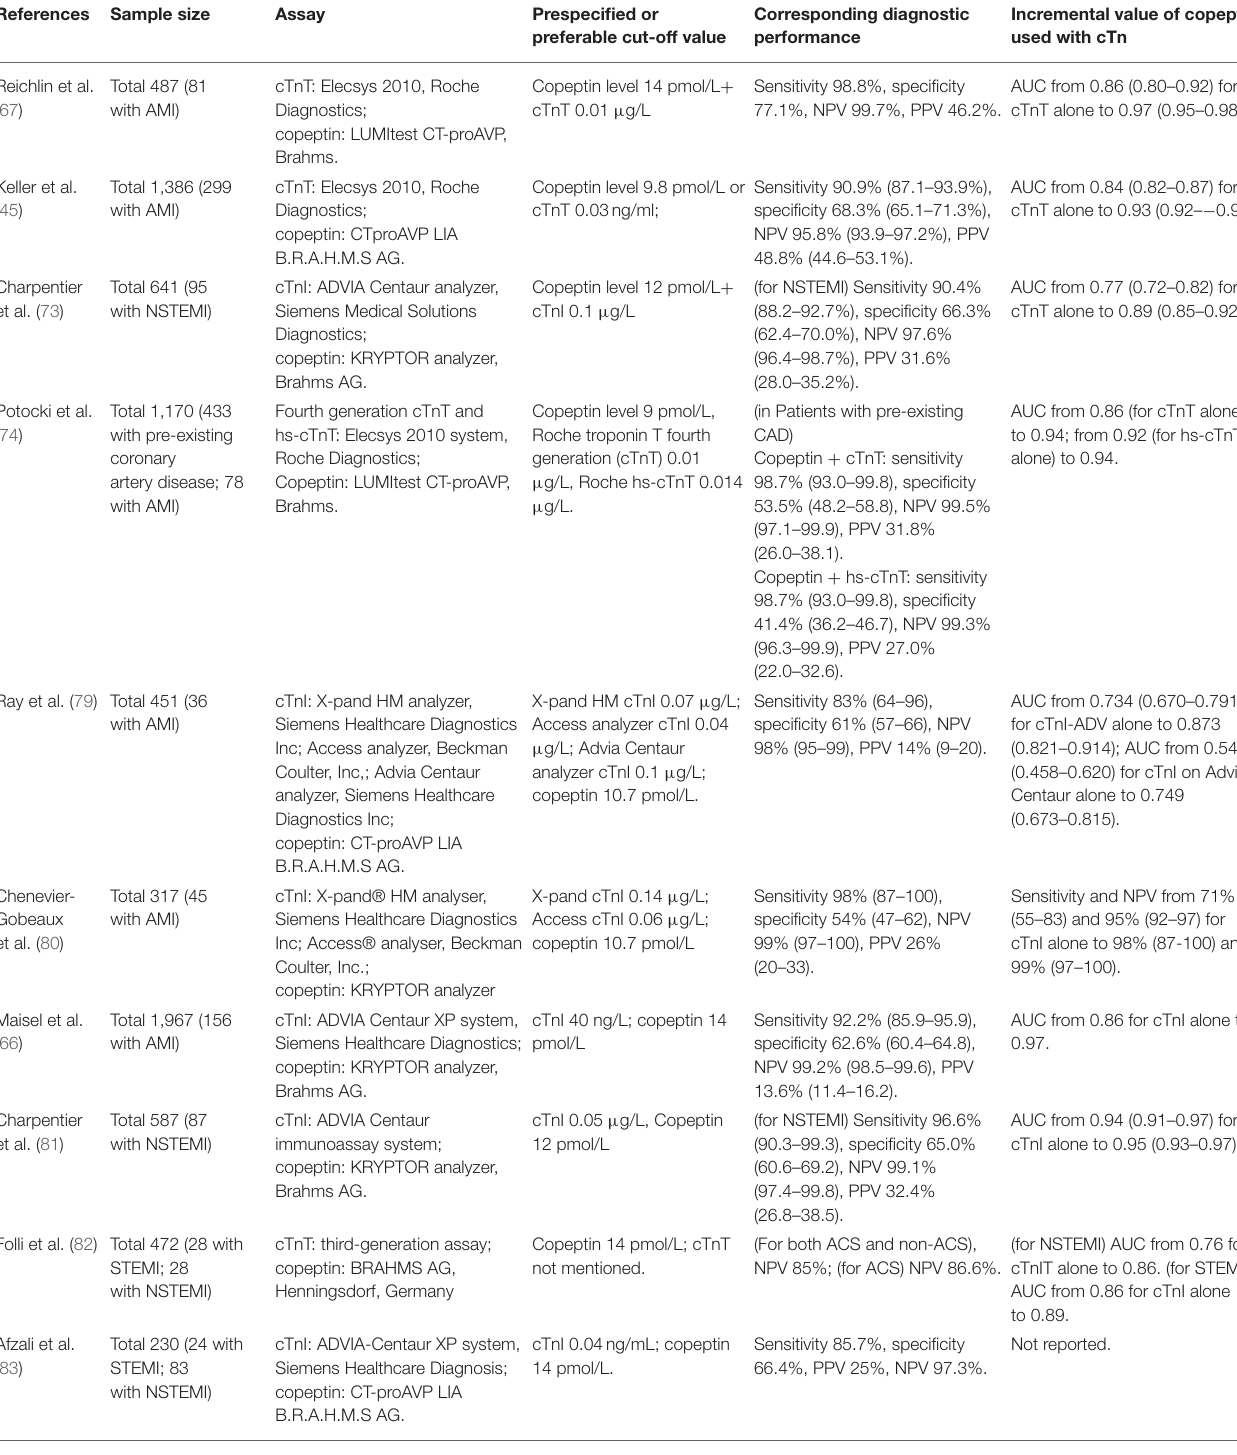
TABLE 2 | Articles about the diagnostic performance of cTn (with or without hs-cTn) combined with copeptin measurement in the rule-out of AMI. References Sample size Assay Prespecified or